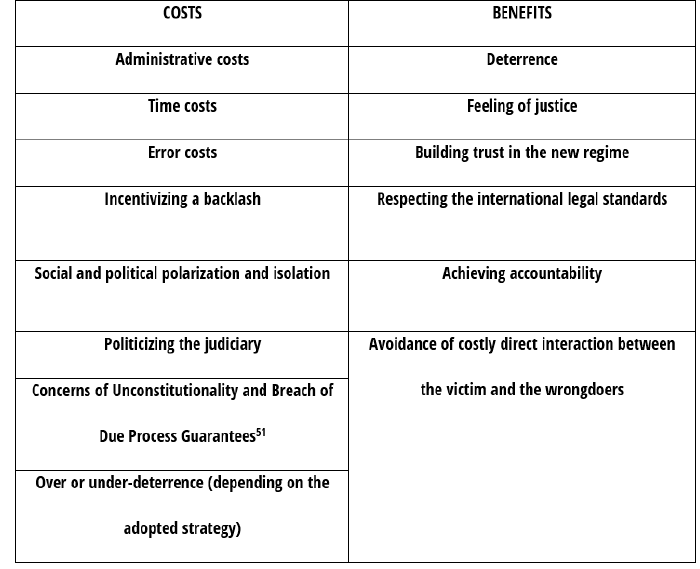
Figure 1: Table (1) Cost-Benefit Matrix of Prosecution Initiatives as a T.J.